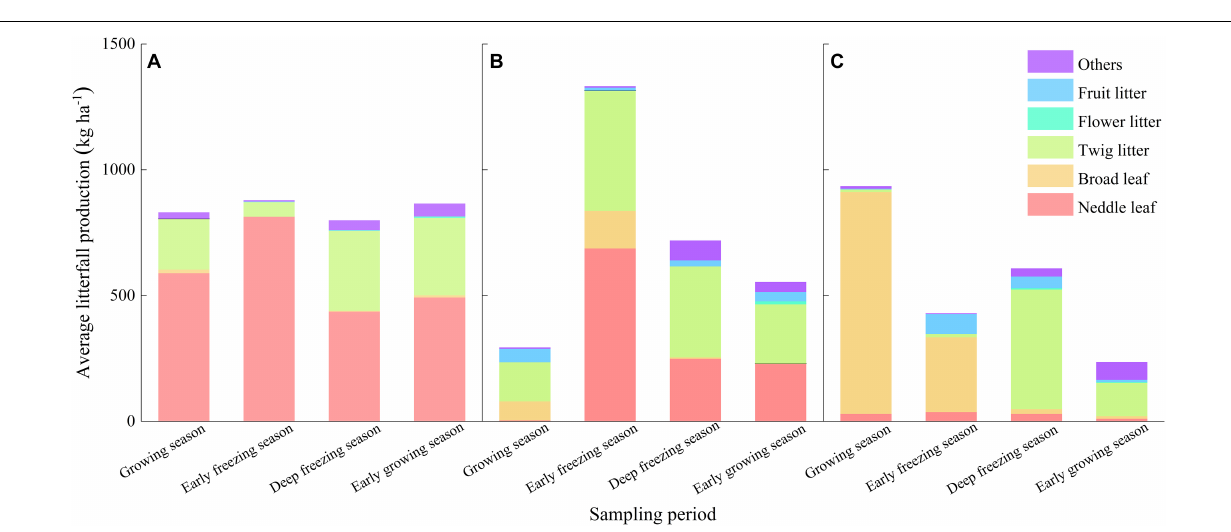
FIGURE 2 | Average production of different litter components in the three forests in the different sampling periods on the eastern Tibetan Plateau: (A) coniferous forest, (B) mixed forest, and (C) broadleaved